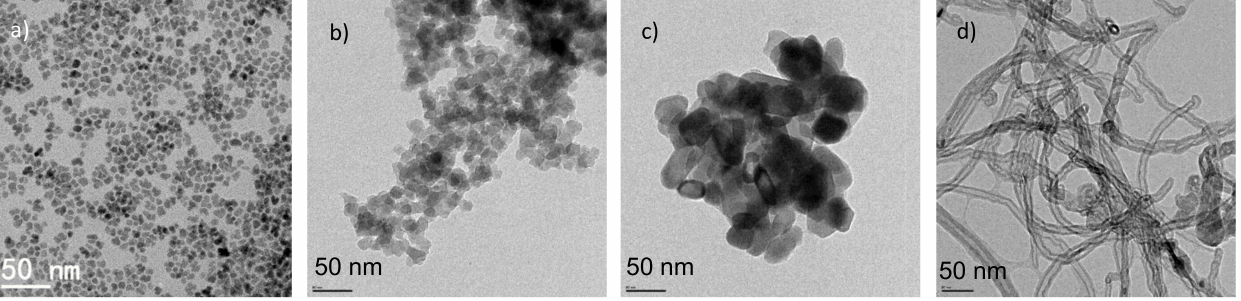
Figure 1. TEM image of: ( a ) synthesized Fe 3 O 4 nanoparticle; ( b ) SiO 2 , NP in ethanol; ( c ) TiO 2 NP in ethanol; and ( d ) multiwalled carbon nanotubes (MWCNTs) in